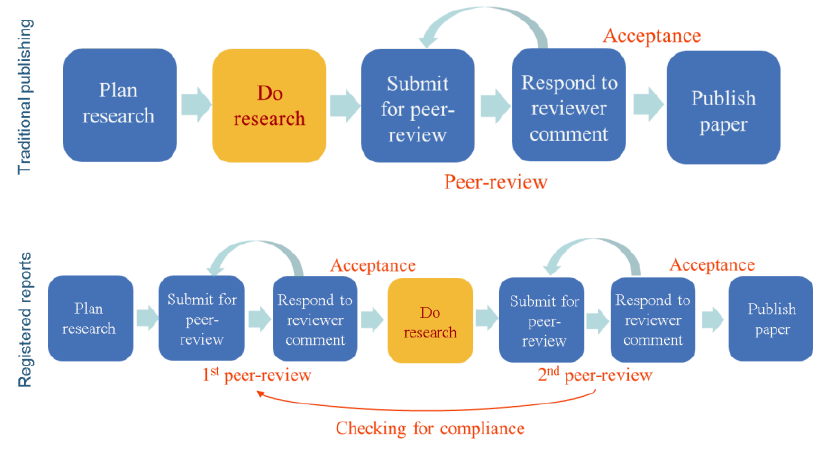
Fig. 6. Study pre-registration and traditional research & publishing